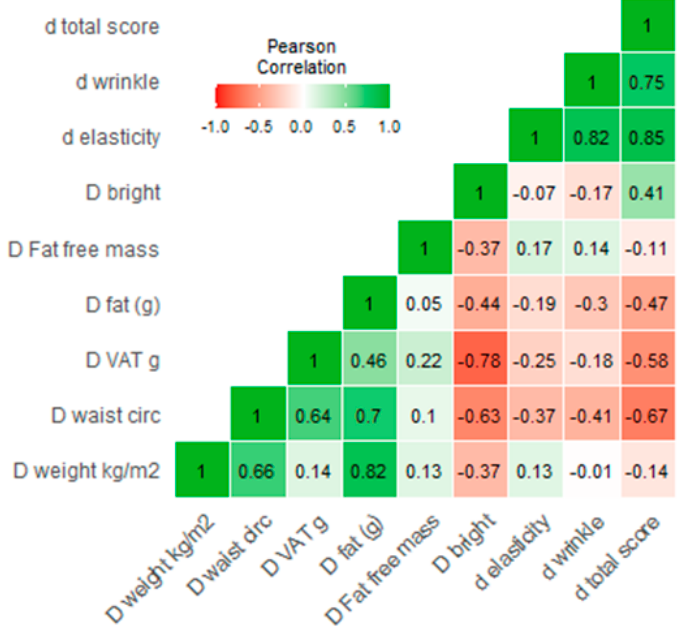
Figure 2. Correlation heatmap showed the association between the delta changes for intervention group.